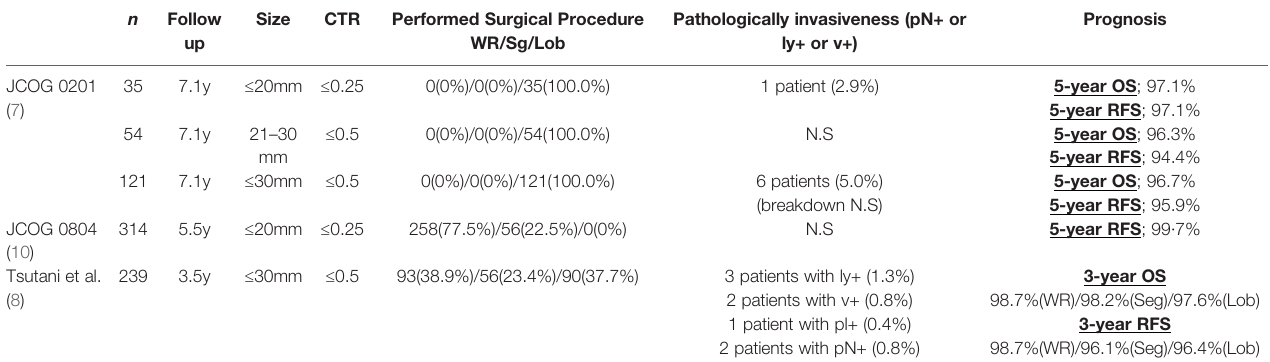
TABLE 1 | Summary of previous large cohort studies evaluating GGO dominant